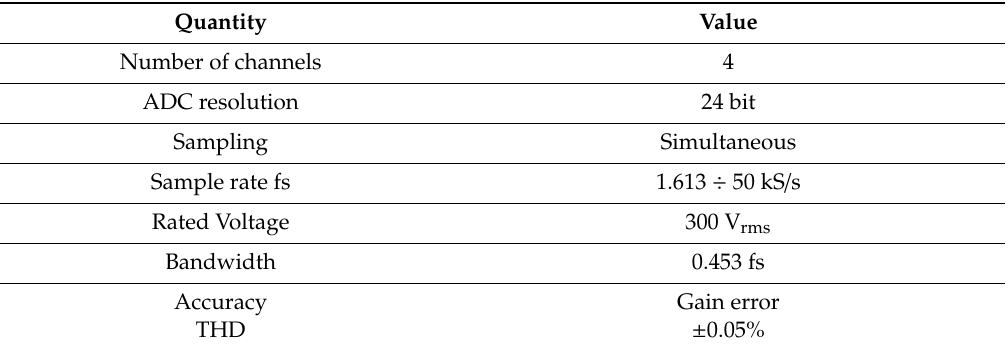
Table 2. Technical data for the NI 9225 acquisition module.